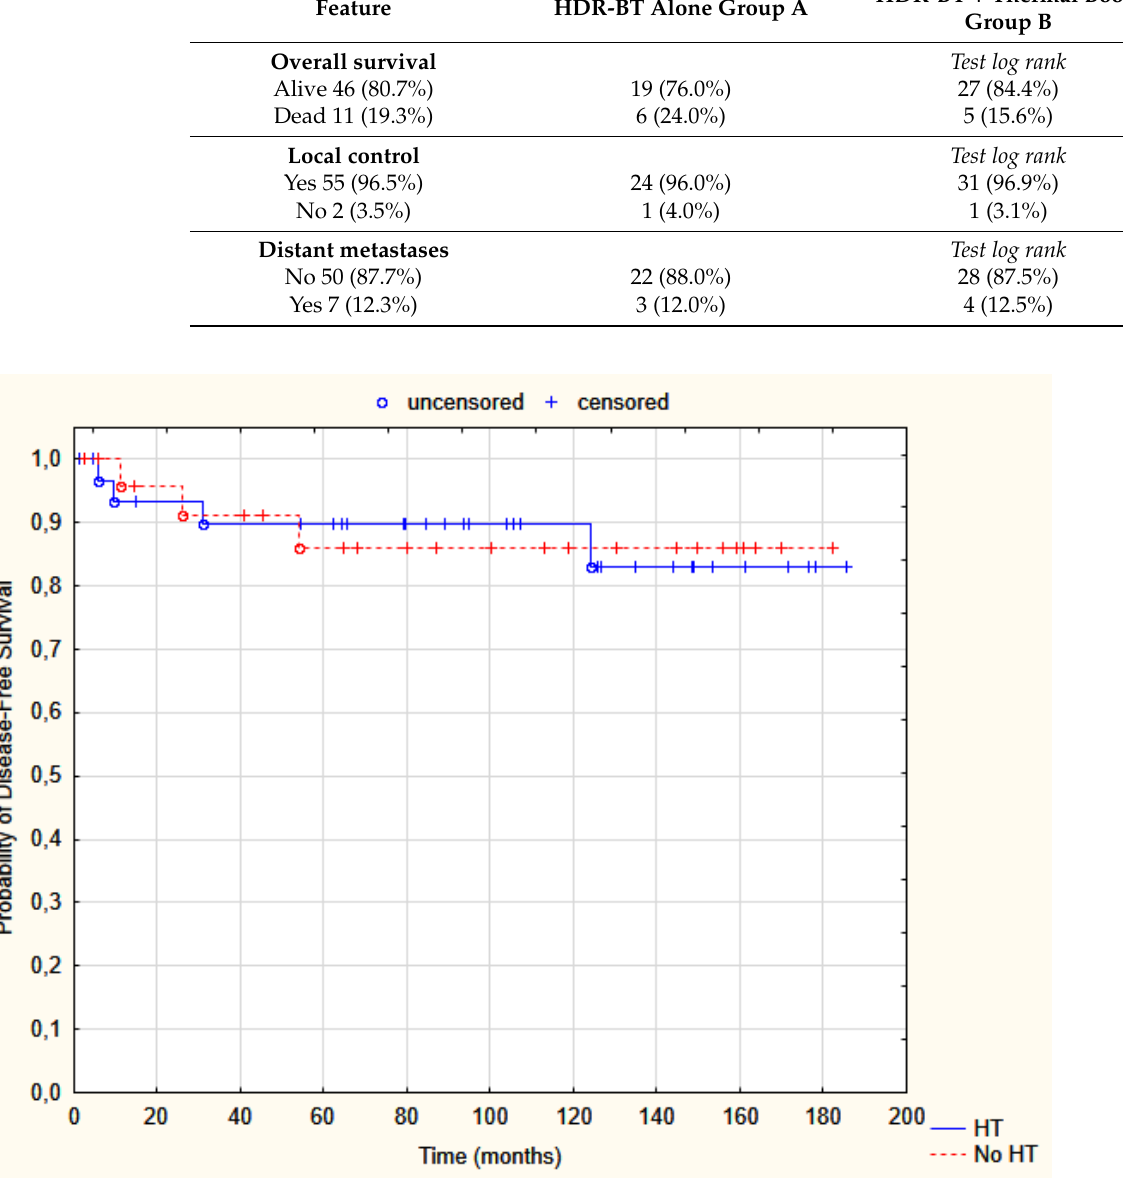
Figure 2. Probability of disease-free survival in group A, HDR-BT (red dotted line), and B, HDR-BT + thermal boost (solid blue line); Test log-rank, p = 0.98. HT—hyperthermia.